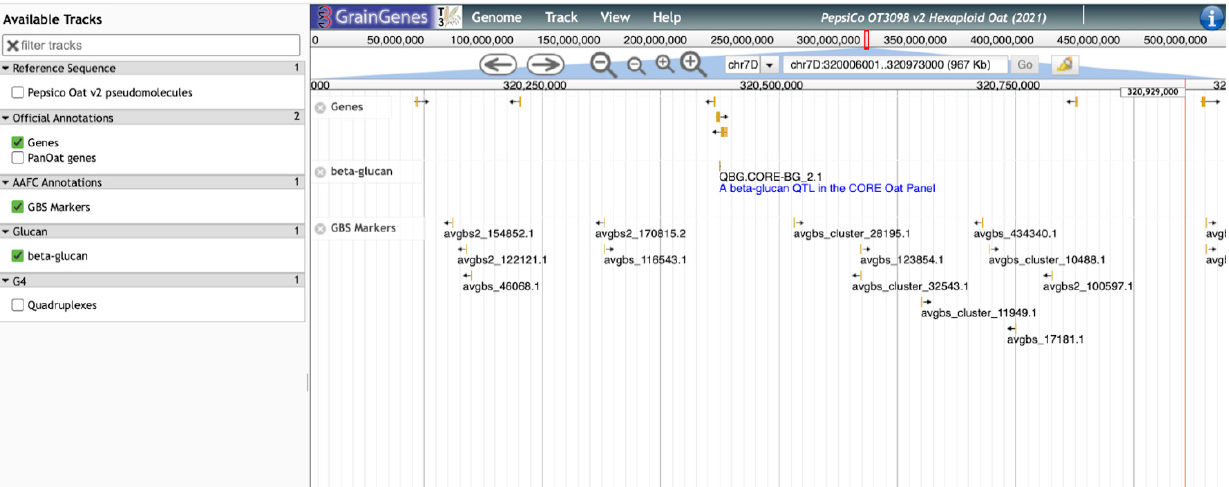
Figure 6. A ‘zoomed-in’ view of the QTL from Figure 5. Additional tracks show annotated genes and SNP markers.